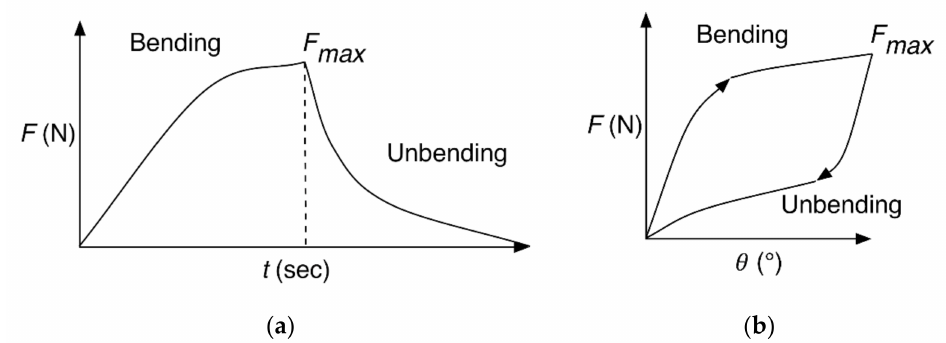
Figure 2. ( a ) Force as a function of time, as it is recorded in the data logs; ( b ) Force vs. angle. F ( θ ) is not